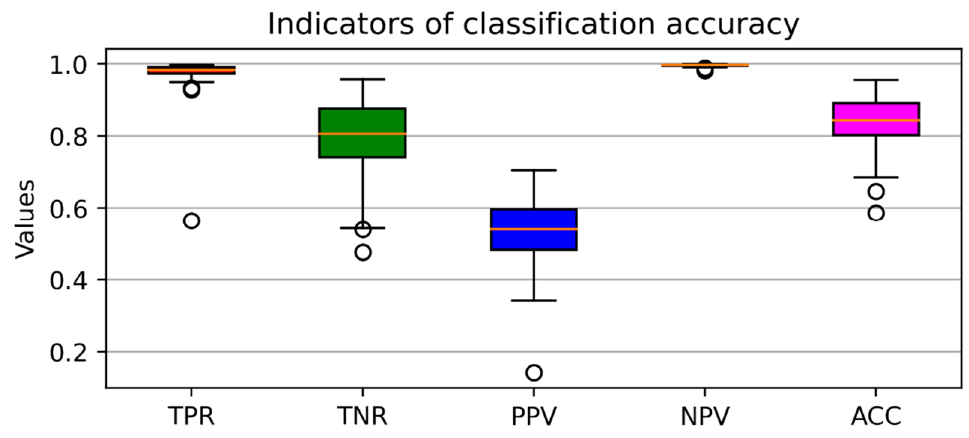
Figure 8. Boxplots showing the variance of classification accuracy indicators during the first 120 days of the test year 2009.